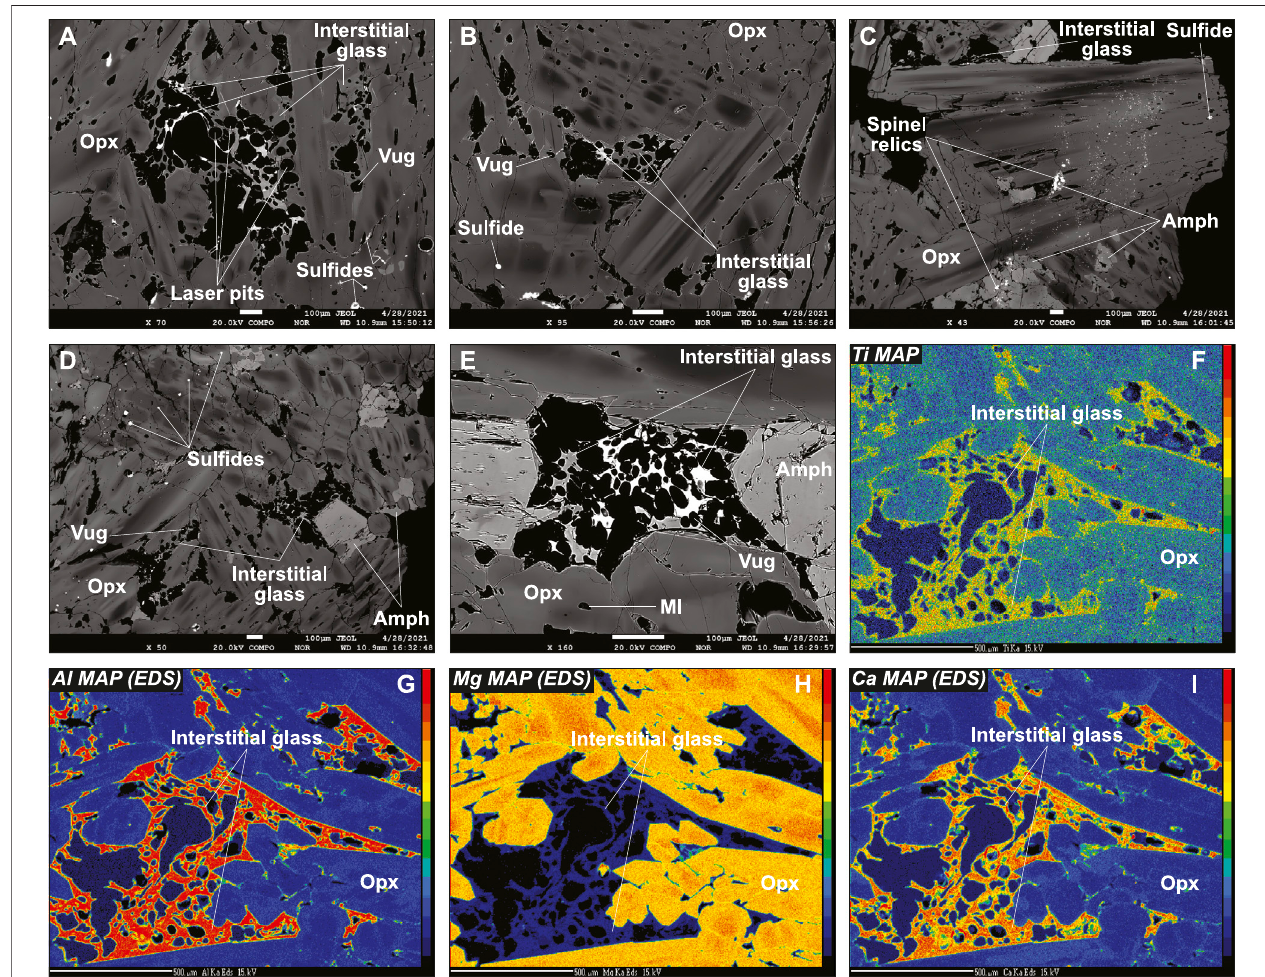
FIGURE1| TexturalfeaturesoftheType1AveincuttingthenewKamchatkasampleAv55inthisstudy.DataacquiredusingEPMA. (A – E) Back-scatteredelectron (BSE) images and (F – I) major element maps. Scale bar is 100 μ m in (A – E) and 500 μ m in (F – I) . The elements mapped in (F – I) are indicated in the top left corners of the images. Note the strong chemical zoning of opx and the variable contrast of the interstitial glass. Amph, amphibole.